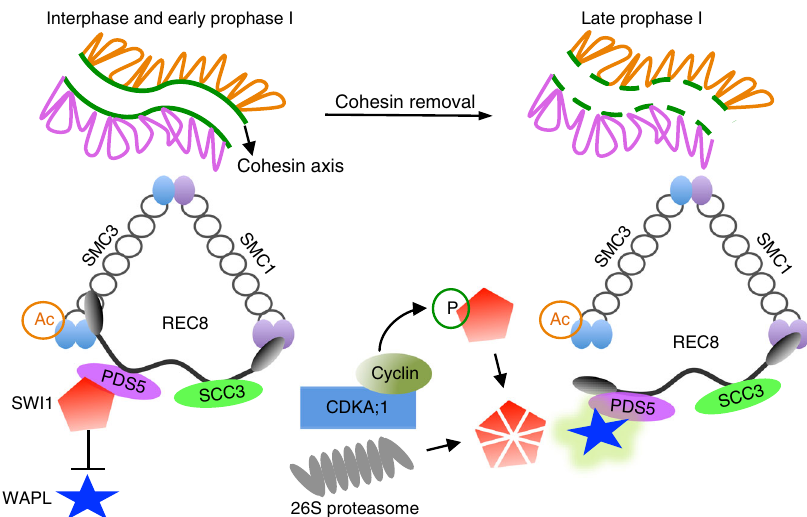
Fig. 10 Model for the role of SWI1 in the regulation of cohesin. During interphase and early prophase I, SWI1 is highly expressed and is recruited to chromatin through interacting with PDS5 family proteins, which in turn inhibits the action of WAPL by dislodging WAPL from PDS5. In late prophase I, SWI1 is phosphorylated by CDKA;1. This phosphorylation of SWI1 then promotes its release from chromatin by facilitating the ubiquitination by APC/C, and subsequent degradation by the 26S proteasome. The release of SWI1 allows the binding of WAPL to PDS5 resulting in the release of cohesin from